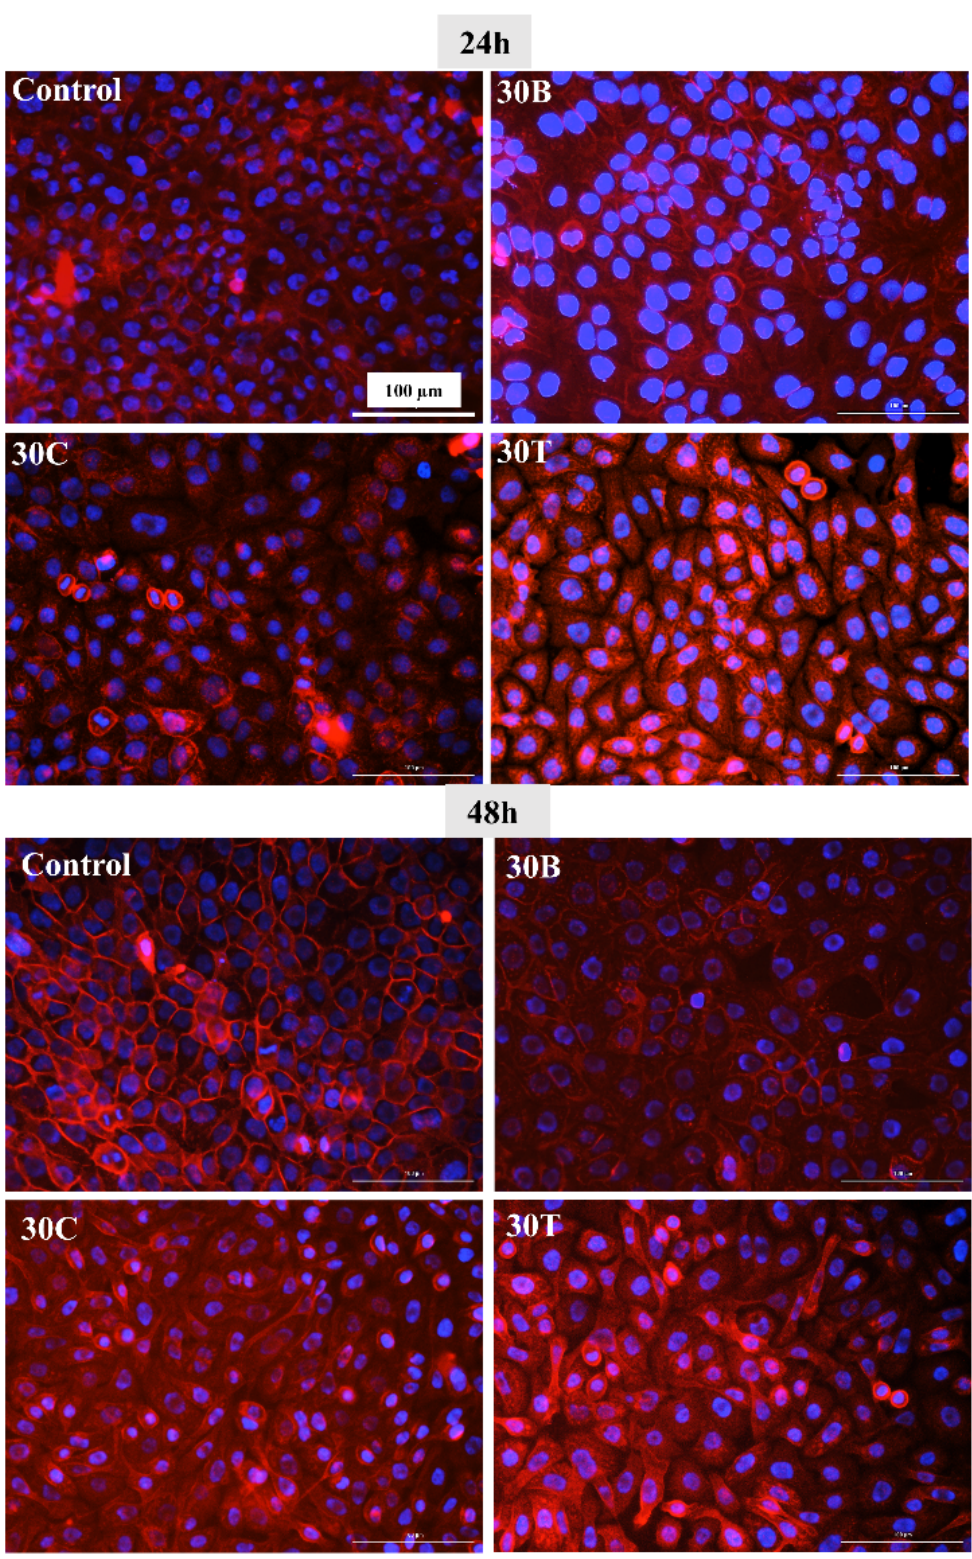
Figure 7. Morphological images (Cytation 3, 20X) of HaCaT cells after 24 h and 48 h of treatment with mini gel prepared from 100 µL of 30B, 30C, 30T, and control. All images were recorded under the same conditions and presented with the same magnification for comparison.